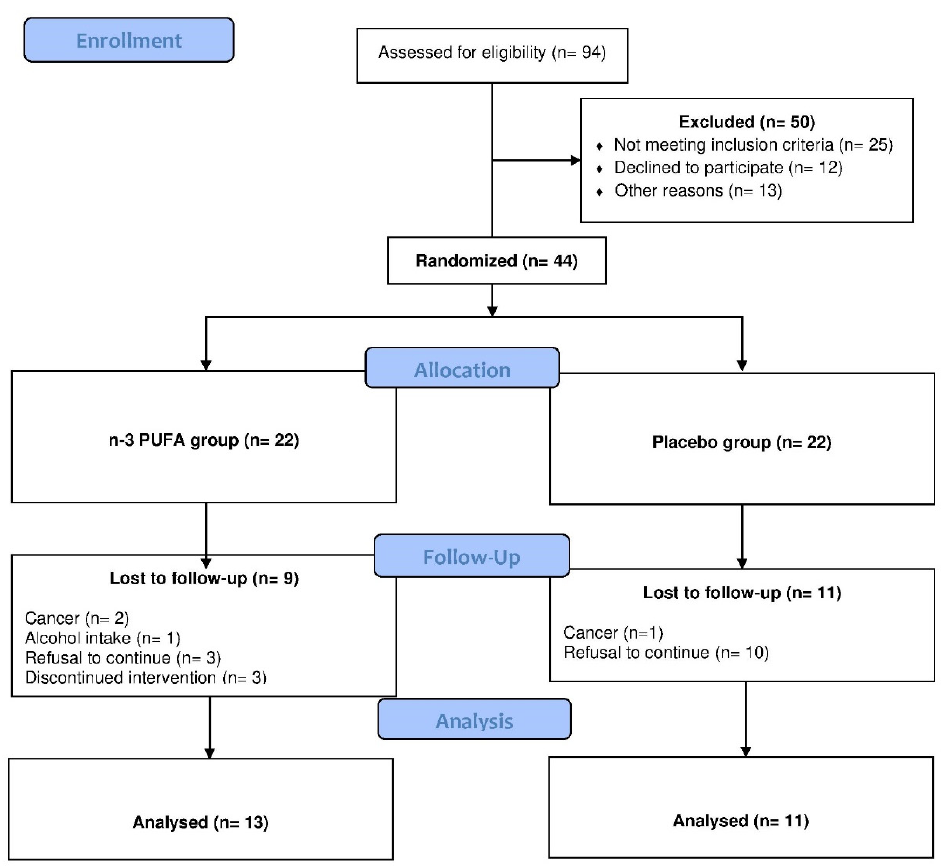
Figure 1. CONSORT flow chart of participant flow. Table 1. Demographic, clinical, and biochemical variables of patients with non-alcoholic fatty liver disease (NAFLD) included in the